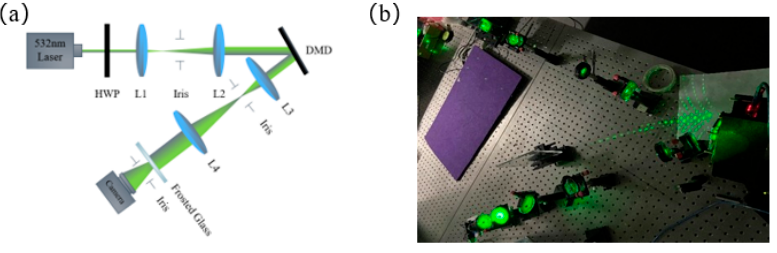
Figure 6. ( a ) Experimental data acquisition optical path diagram; and ( b ) real experimental environ- ment based on the optical path diagram.